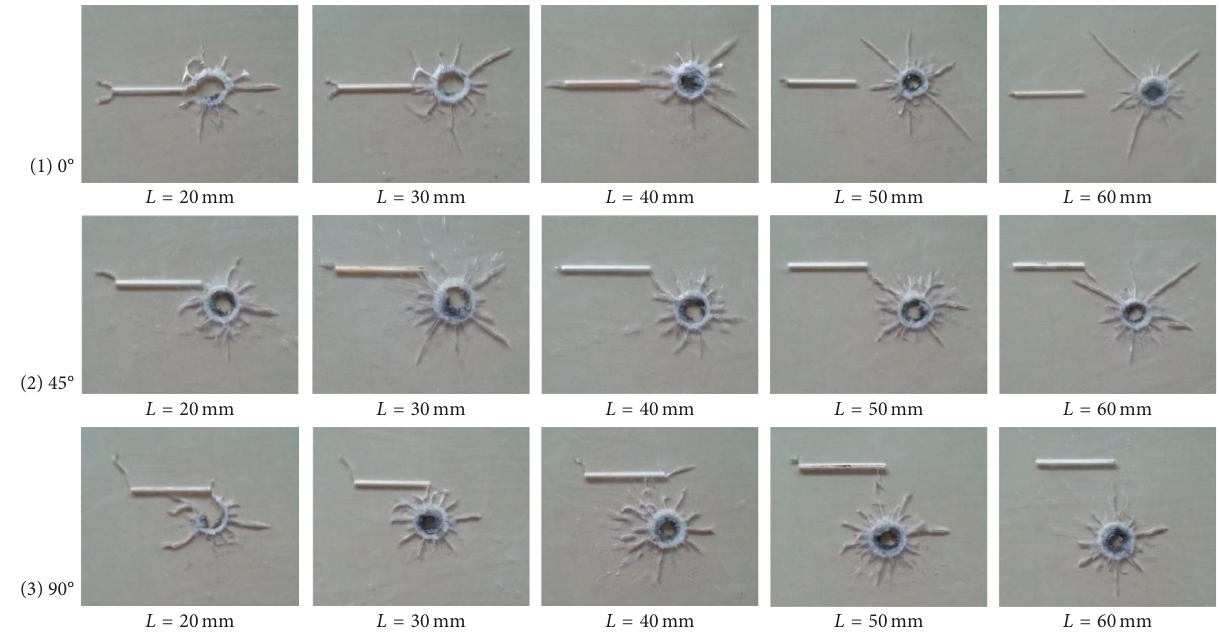
Figure 3: Soil-filled PMMA specimens after explosion.